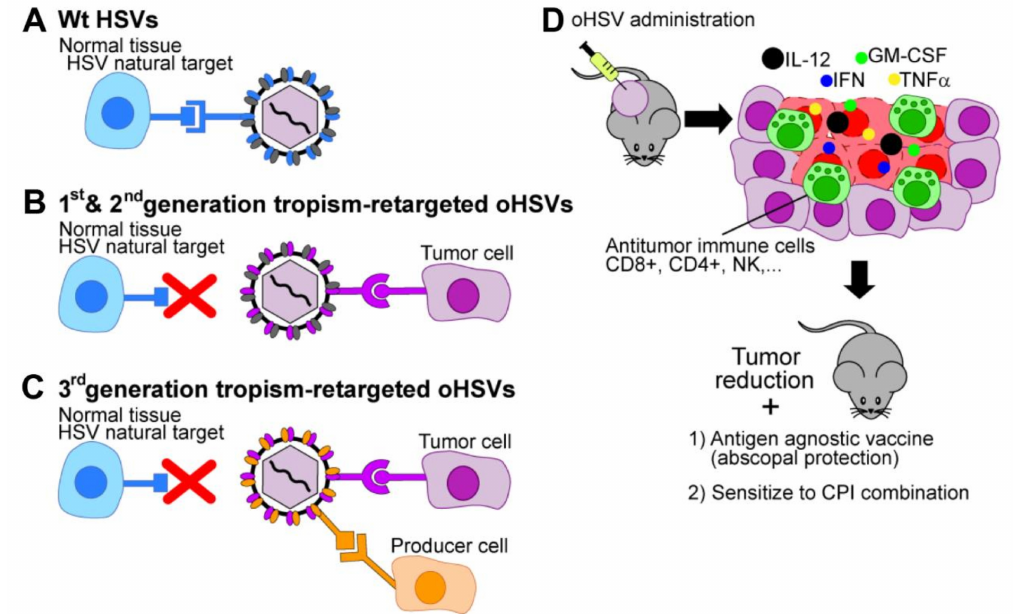
Figure 1. Schematic view of HSV tropism retargeting and immunotherapy induced by armed oHSVs. ( A – D ). ( A ) wt-HSV infects normal tissues, i.e., its natural target cells through natural major receptors HVEM and nectin1 (blue). ( B ) 1st and 2nd generation tropism retargeted oHSVs infect cancer cells expressing the target Tumor Associated Antigen (TAA, violet) and fails to infect its natural targets. The scFv to TAA which mediated the virus retargeting to cancer cells is engineered in the following virion glycoproteins: gD (1st generation), either gB or gH (2nd generation). ( C ) 3rd generation tropism retargeted oHSV, can infect both the cancer cells that express the target TAA (violet) and the producer cells that express an artificial receptor (orange), and fails to infect its natural targets. ( D ) The IL-12-armed retargeted oHSV specifically infects tumors cells, causes immunogenic cell death of cancer cells and elicits immuno-therapeutic response, that result in inhibition of tumor growth, sensitization to checkpoint blockade and antigen-agnostic